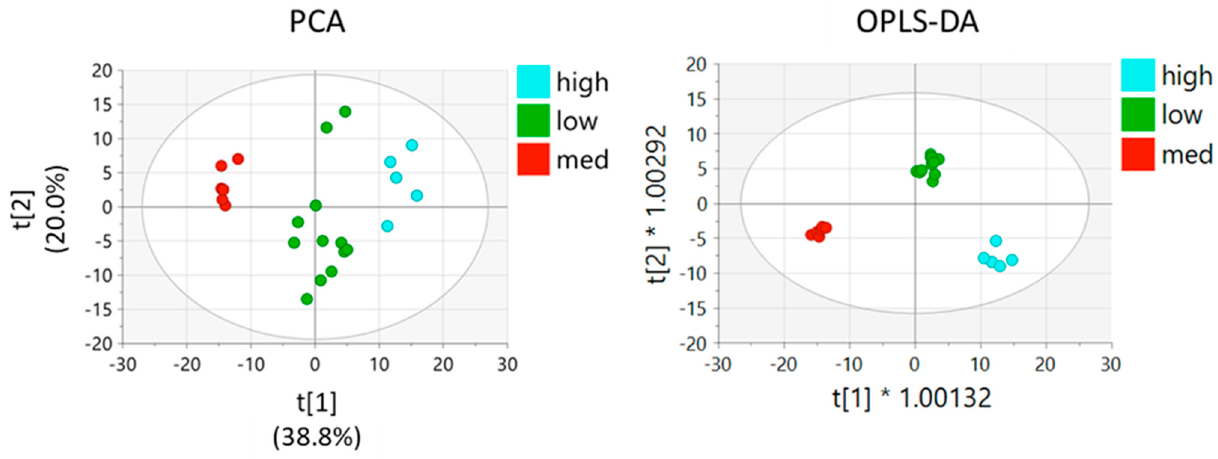
Figure 5. Analysis of metabolomics data (PCA and OPLS-DA) based on the ALDH1L1 expression levels in three-groups (WT RT4 cells with high levels of ALDH1L1, high group; clone 506 with intermediate levels of ALDH1L1, medium group; L1-CR and 572 clones, low/undetectable ALDH1L1, low group).